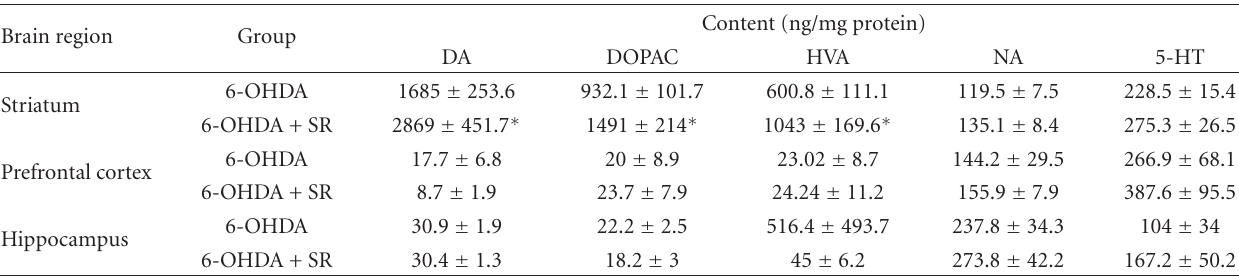
Table 1: E ff ects of acute administration of SR141716A (3mg/kg) i.p. on neurotransmitter levels in the striatum, prefrontal cortex, and hippocampus one week after 6-OHDA administration. Results are expressed as mean ± SEM in comparison to the 6-OHDA group. Statistical analysis was performed by unpaired Student’s t -test.